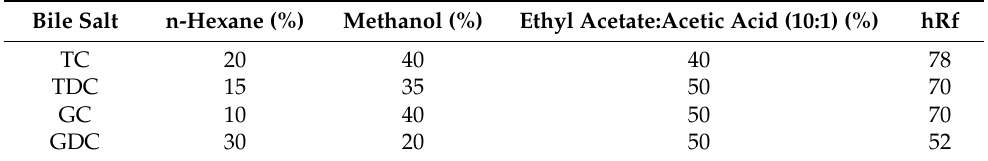
Table 1. Composition of the optimized developing solvents for the determination of four bile salts by